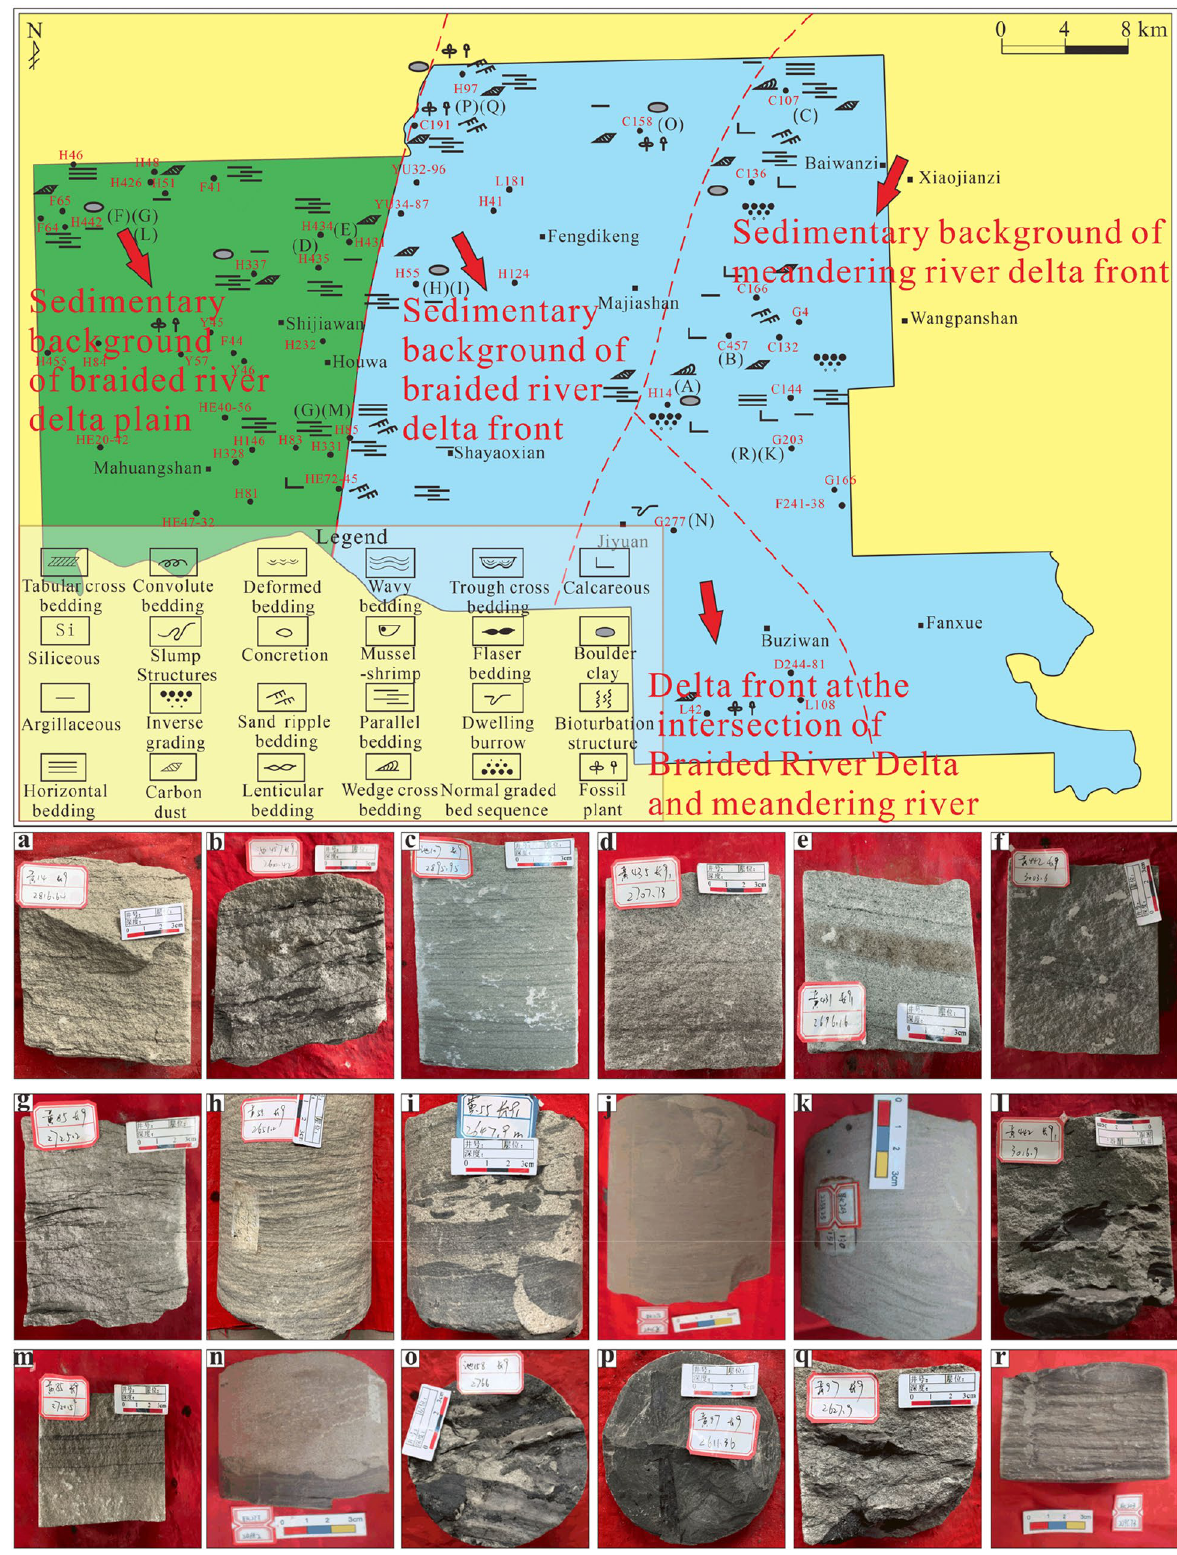
Figure 7. The planar distribution of sedimentary structures in the oil-bearing Chang 9